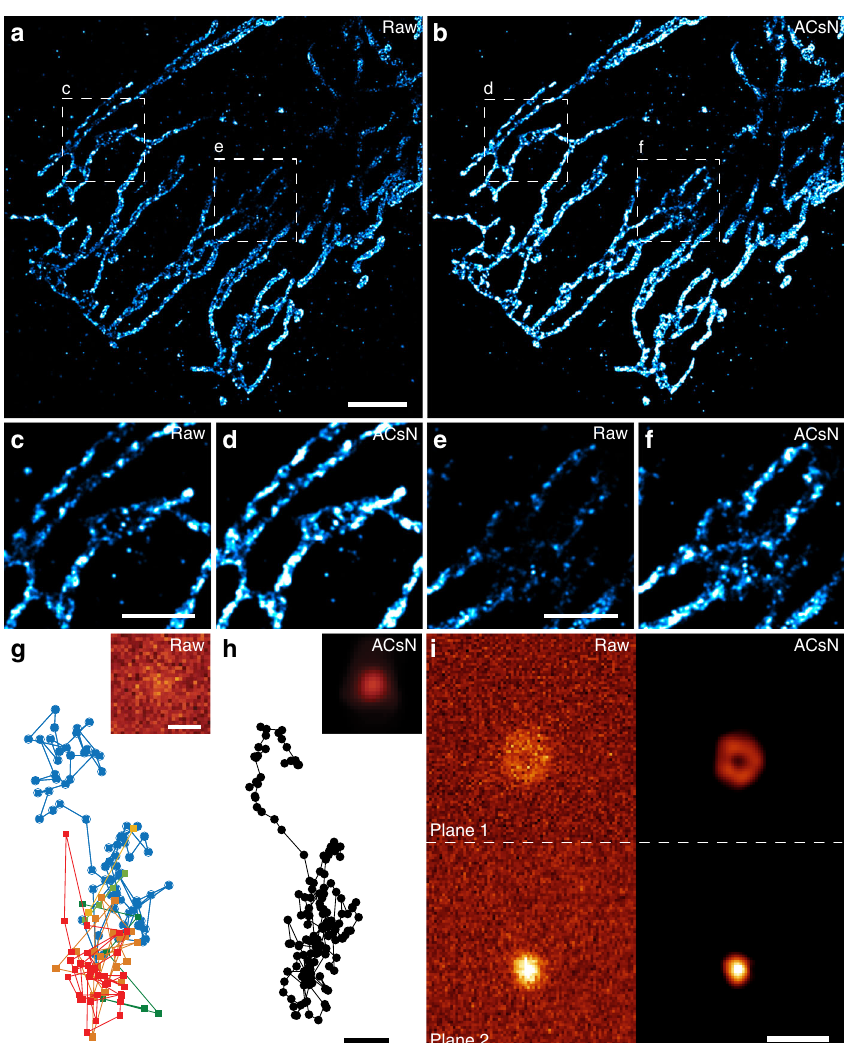
Fig. 4 ACsN improves localization performance in STORM and single-particle tracking. a STORM image of mitochondria in a fi xed HeLa cell (RSP: 0.81, RSE: 40.6). b STORM image reconstructed after ACsN denoising of raw single-molecule data of a (RSP: 0.85, RSE: 36.7). In both cases, 5000 single- molecule frames were used. Representative frames of the raw data before and after denoising are shown in Supplementary Fig. 3. Quantitative image analysis with NanoJ-SQUIRREL assessed an improvement of both RSP ( + 0.04) and RSE ( − 3.9) values in b compared to a . It is observed that the number of localizations in b is increased in comparison with a , which leads to a better contrast in the former and to the appearance of features not visible in the latter ( c – f ). g Single-particle tracking of a fl uorescent bead recorded with a 1 ms exposure time. A representative frame is shown in the inset. Each color corresponds to one of the six different tracks detected. h Single-particle tracking of the same bead in g after ACsN denoising (inset). The improved SNR yields a better localization accuracy, which results in a single, smooth trajectory (black line). i Representative frame for biplane single-particle tracking at 1 kHz frame rate (exposure time: 1 ms) before (left) and after (right) ACsN denoising. Scale bars: 4 µ m ( a ), 2 µ m ( c , e , i ), 1 μ m ( g , inset), 250 nm ( h